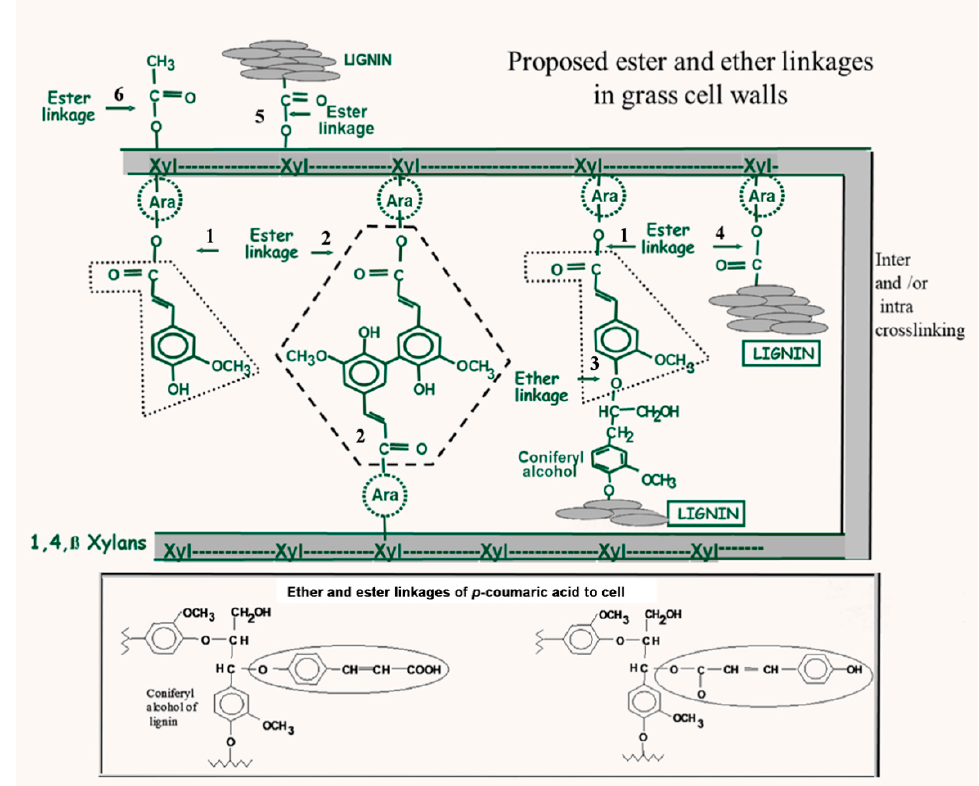
Figure 2. Schematic structure of ferulic acid (FA) cross-linking arabinoxylan (AX) and lignin in grass cell walls . The main β -(1,4)-linked xylan (Xyl) backbone is illustrated by dotted lines, the arabinose (Ara) side sugars are shown in circles and lignin is shown as gray-filled circles. Ester and ether bonds are shown by arrows as follows: 1 . FA ester linked to AX. 2 . 5-5- ester linked to FA dimer cross-linking AX chains. 3 . FA ether linked to lignin. 4 . AX ester linked to lignin. 5 . Xylan ester linked to lignin. 6 . Acetyl group ester linked to xylan. Modified from Williamson et al. (1998) [9]. Unpublished original data. Source P. Morris & M. Buanafina.